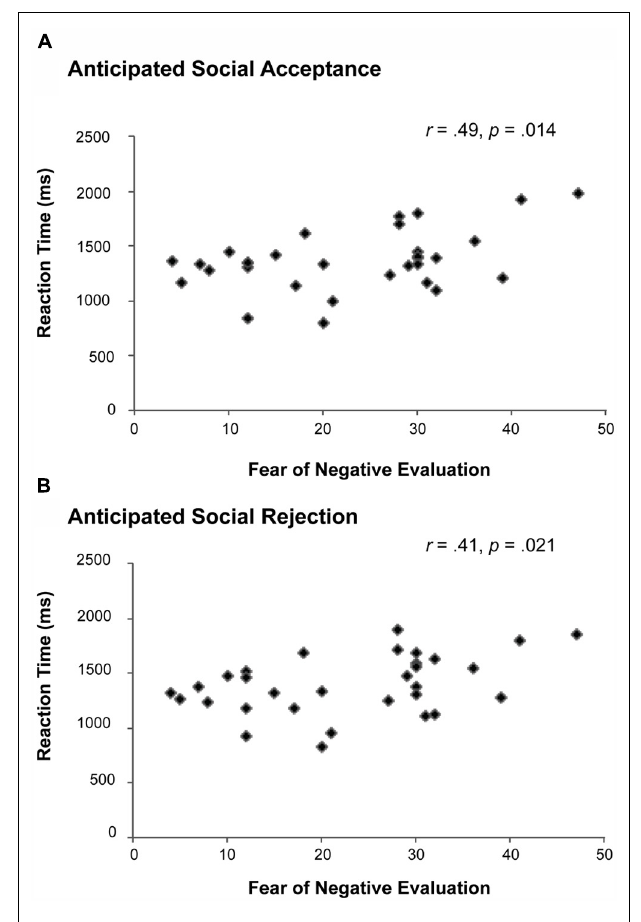
FIGURE 2 | Correlations between the Fear of Negative Evaluation (FNE) and the RT of social acceptance (A) and social rejection (B) judgments. Individuals with higher levels of FNE needed significantly more time to provide both social acceptance (“YES”) and social rejection (“NO”) judgments.